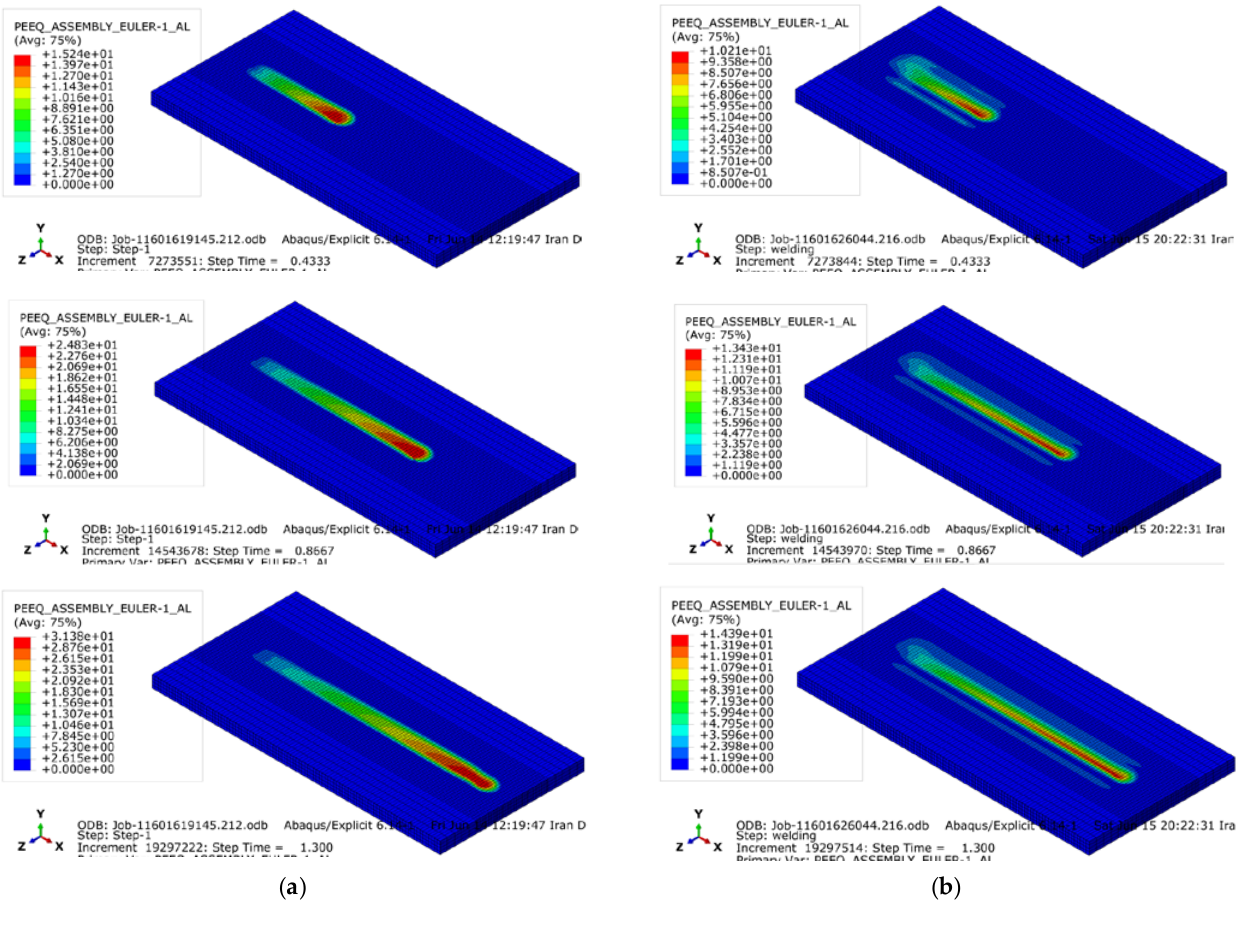
Figure 13. Three-dimensional view of the equivalent plastic strain ( a ) without the tilt angle, and ( b ) with the tilt angle.